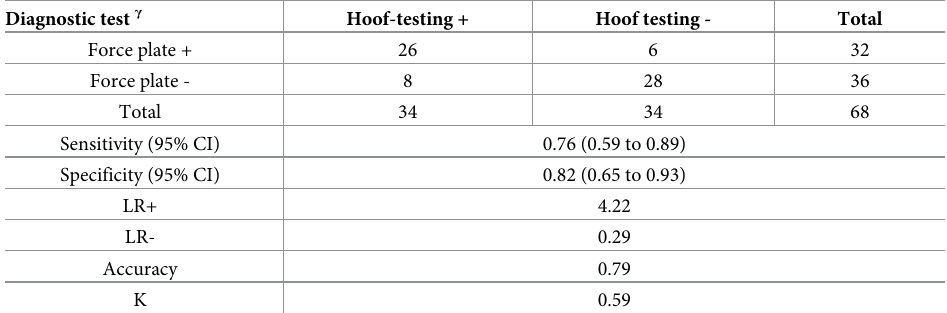
Table 5. Comparison of the force plate with the gold standard hoof testing for the diagnosis of oligofructose- induced laminitis in cattle.